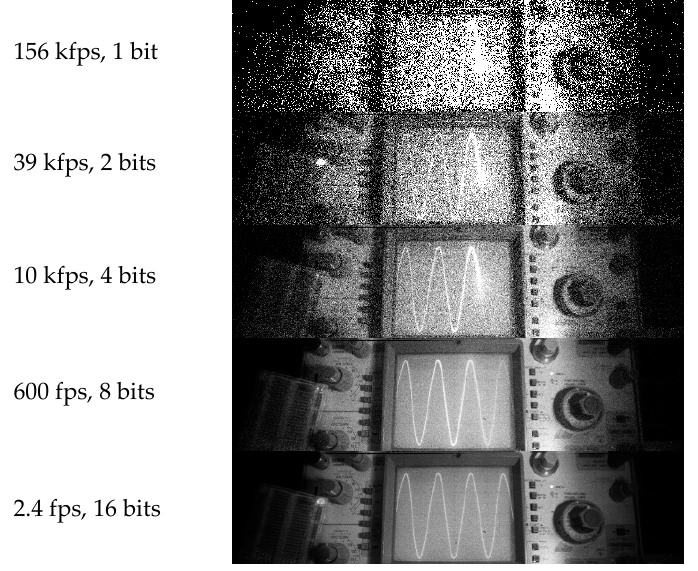
Figure 17. Tradeoff between effective number of bits (ENOB) and frame rate, from 156 kfps to 2.4 fps [23].